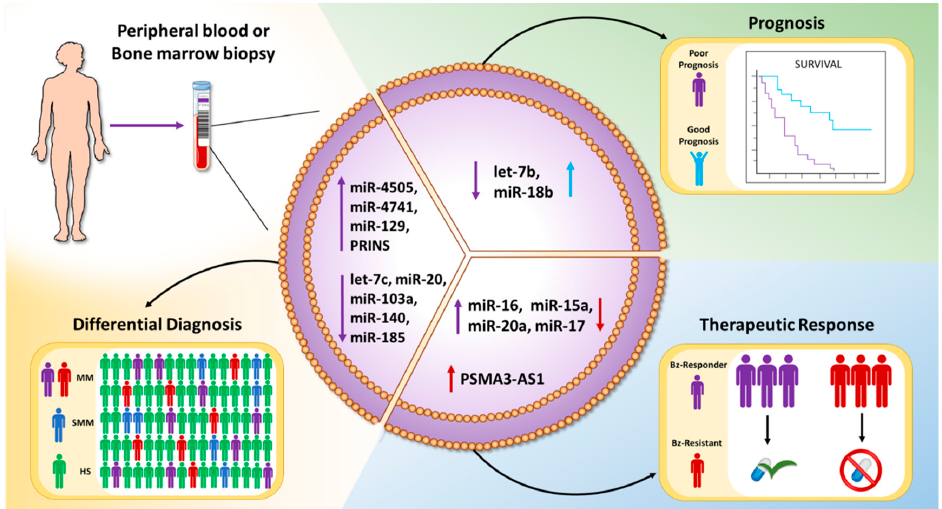
Figure 2. Schematic representation of the clinical value of EV-associated ncRNAs: EVs can be isolated from the peripheral blood or the bone marrow aspirates of patients with different gammopathies. EV-ncRNAs may serve as biomarkers for the differential diagnosis, prognosis, or prediction of therapeutic response.